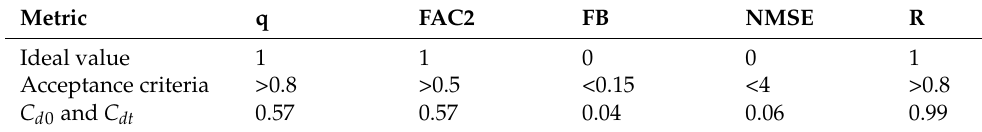
Table 3. Validation metrics for drag characteristics based on LES-medium mesh.